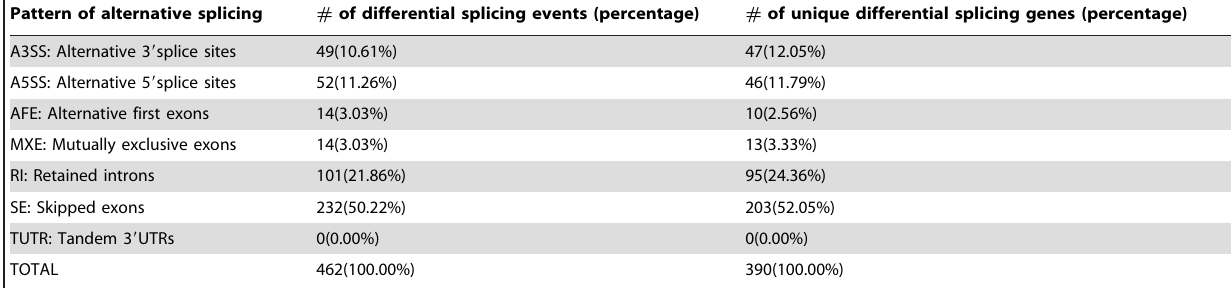
Table 5. Statistics of differential splicing genes in bladder cancer.